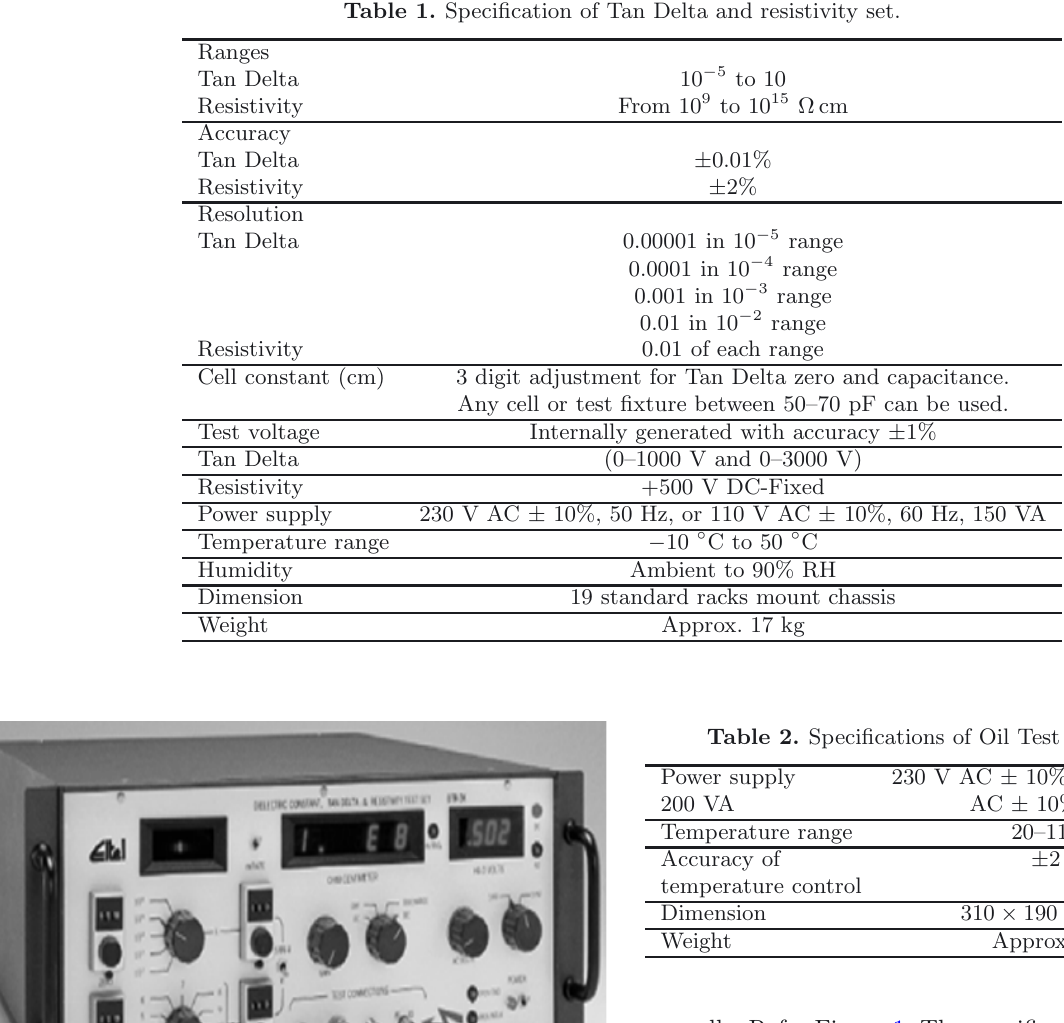
manually. Refer Figure 1. The specifications of Tan Delta and resistivity set are as shown in Table